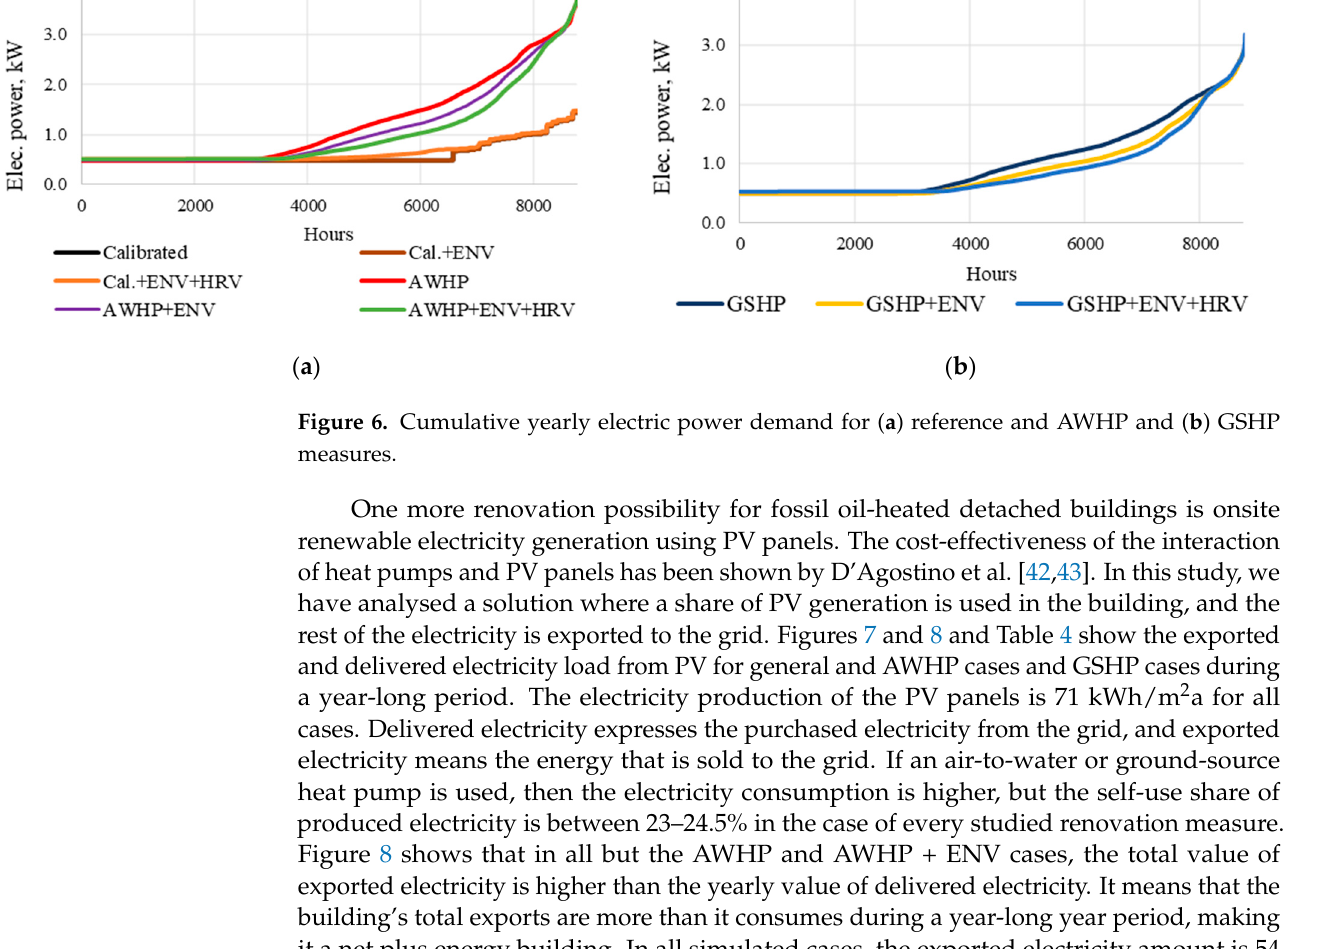
Figure 8. Yearly delivered and exported energy for a reference single-family house for different cases. Table 4. Electricity production in delivered and exported units for different cases. Calibrated